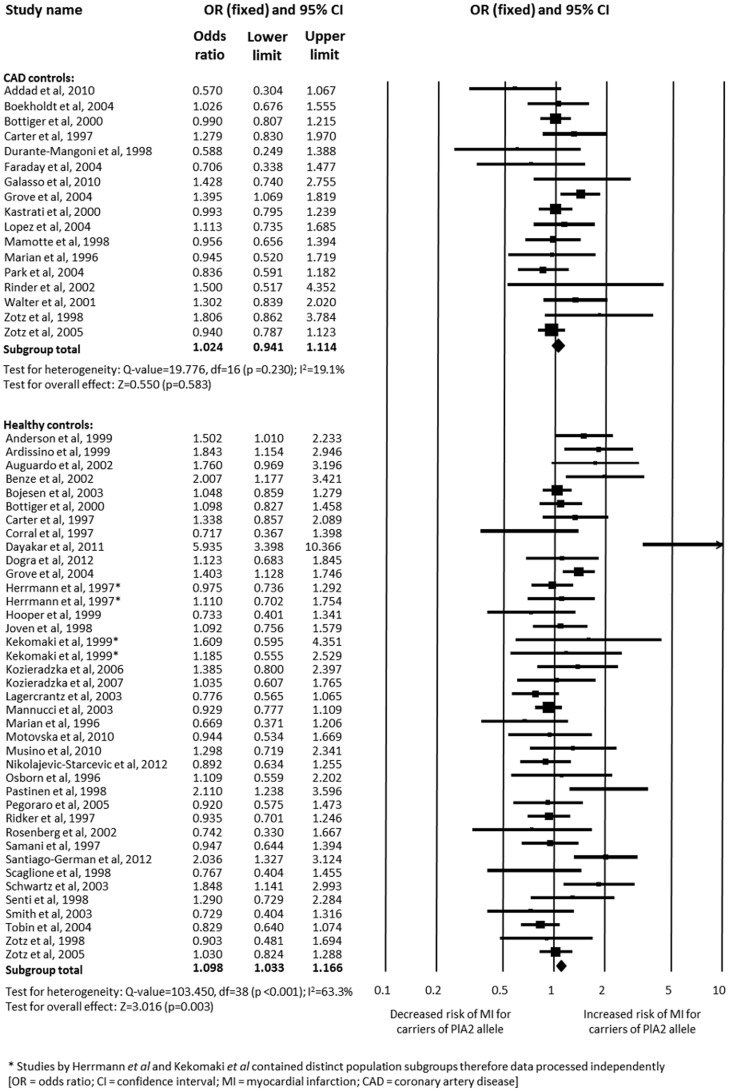
Analysis of the association between carriage of the PlA2 allele and myocardial infarction based on the use of healthy controls or controls with known coronary artery disease.Analysis is of the PlA1/A1 versus PlA1/A2+PlA2/A2 genotype.